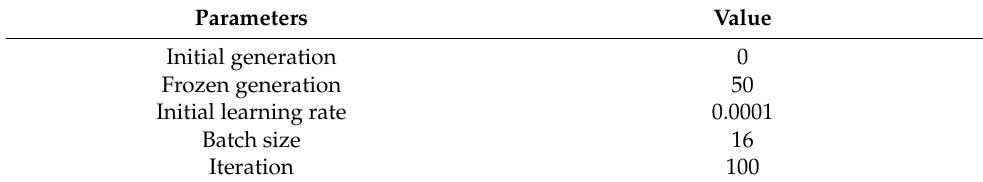
Table 5. Training parameters.